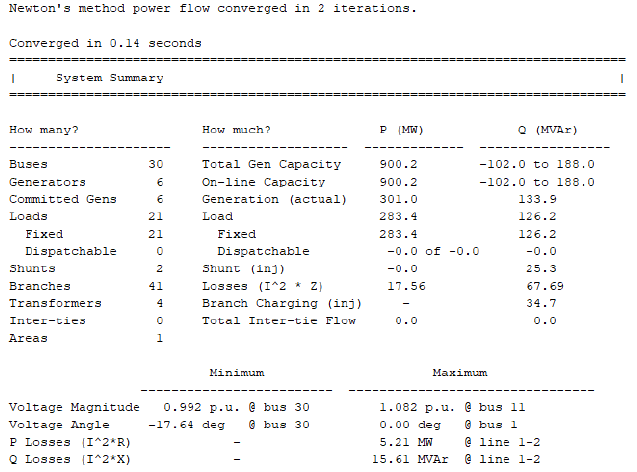
Figure 2. System summary and load flow analysis using Newton-Raphson numerical